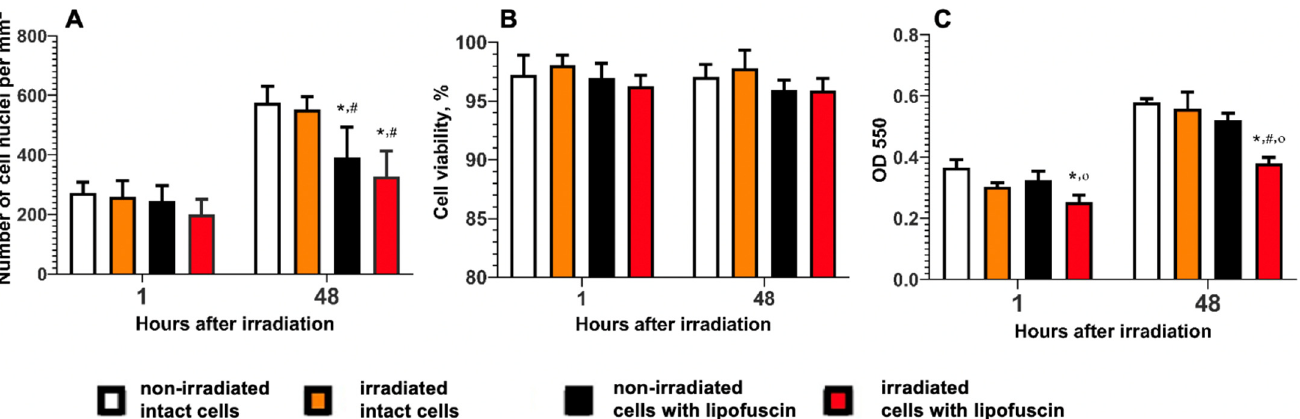
Figure 1. Assessment of the cyto- and phototoxic effects of lipofuscin granules loaded into ARPE-19 cells, depending on the time of incubation after white light irradiation: ( A ) the number of cells per mm 2 ( n = 5); ( B ) results of live/dead test ( n = 5); ( C ) results of MTT assay ( n = 3). The data were analyzed by two-way ANOVA with Tukey’s multiple comparison t-test and represented as means ± standard deviations. * Differences in comparison with the non-irradiated intact (without lipofuscin) cells (control group); # differences in comparison with the irradiated intact cells; ο differences in comparison with non-irradiated cells loaded with lipofuscin.